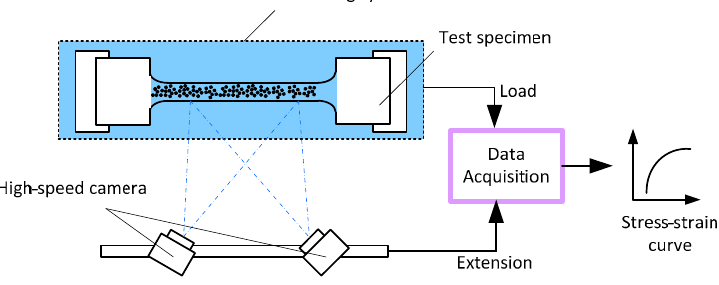
Figure 10. Schematic experimental set-up for tensile testing. Sensors 2016 , 16 , 928